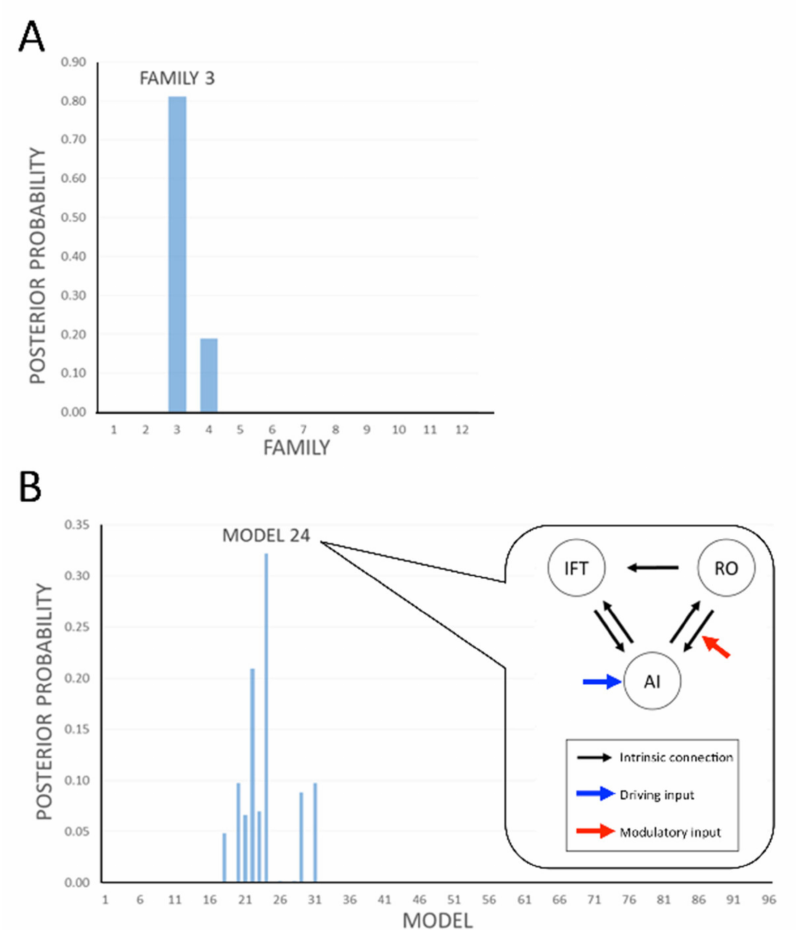
Figure 5. Results of the dynamic causal modelling (DCM) analysis of the flavour network modulated by taste and smell. We compared the results from our data under 96 different models per subject. ( A ) We grouped these into 12 families and pooled the results within each family. A comparison of the families, under the prior assumption that all families were equally likely, gave 81% probability that Family 3 provided the best explanation [that is, models with input at AI which all have modulation observable from RO to AI (Table 1)] for the dataset overall and 18% probability that Family 4 provided the best explanation for the dataset. Considering models within Family 4, the analysis indicated that input at AI has 100% posterior probability (Table 1, first row). ( B ) Within Family 3, model 24 appears to be the best model with 33% posterior probability, suggesting that the main modulation is from RO to AI. AI: anterior insula; RO: rolandic operculum; IFT: inferior frontal